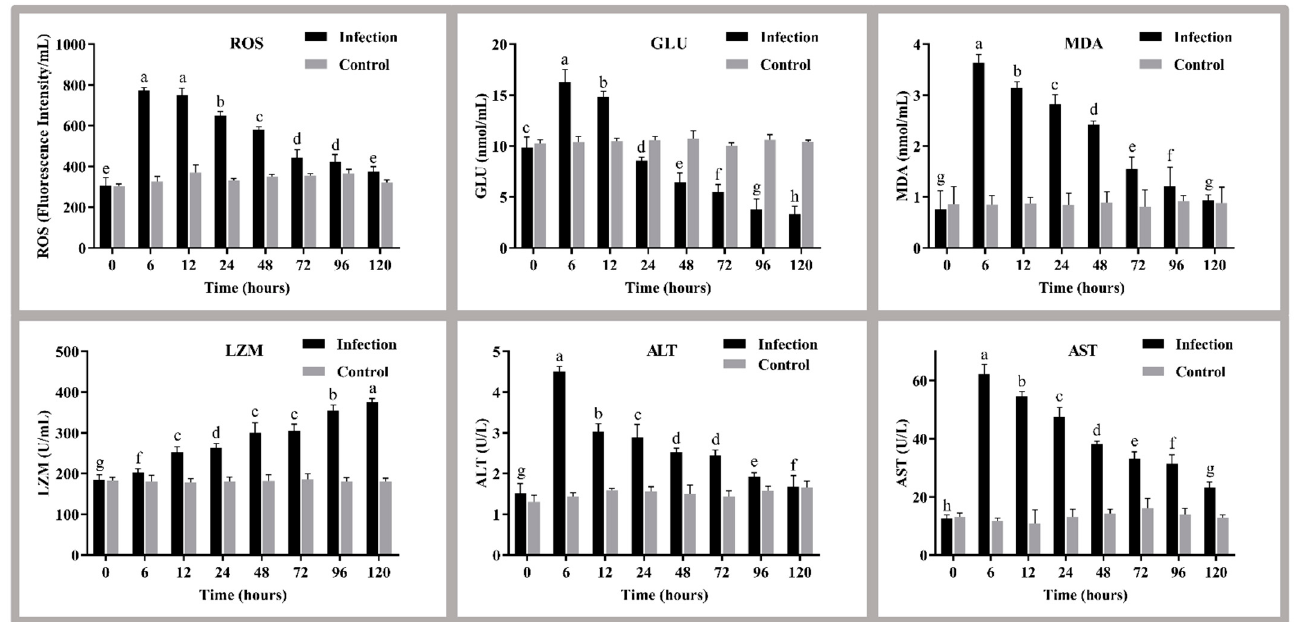
Figure 2. The levels of ROS, GLU, MDA, LZM, ALT, and AST in plasma at different times before and after the challenge. Different letters indicate significant differences between the stress groups ( p < 0.05). Values are the means ± SEs ( n = 3). The grey bars represent the indicators of fish before the challenge, and the black bars represent the indicators of fish after the challenge. ROS, reactive oxygen species; GLU, glucose; MDA; malondialdehyde, LZM, lysozyme; ALT, alanine aminotransferase; AST, aspartate aminotransferase.